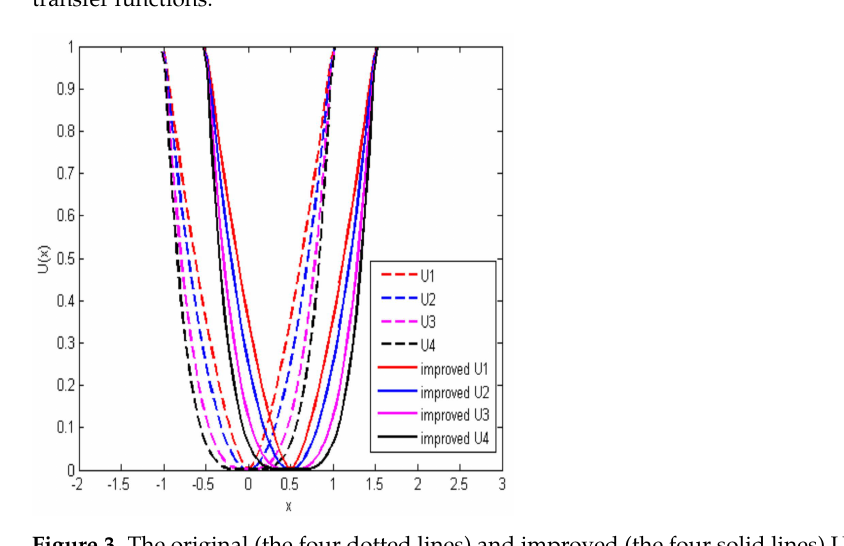
Figure 3. The original (the four dotted lines) and improved (the four solid lines) U-shaped families of transfer functions.